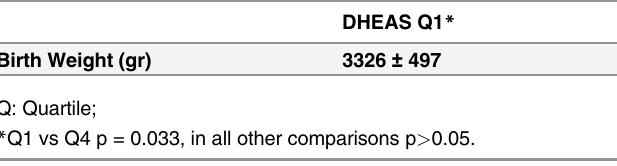
Table 3. Birth weight in women with PCOS according to DHEAS levels